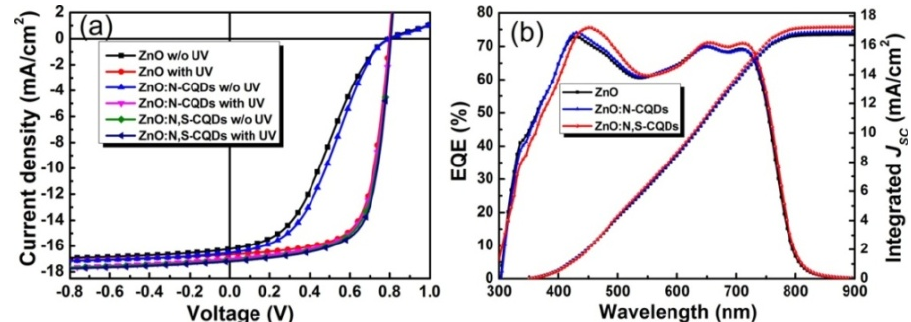
Figure 12. ( a ) J-V curves without and with UV treatment and ( b ) EQE spectra with UV treatment of ZnO-, ZnO:N-CQD-, and ZnO:N,S-CQDs-based PTB7-Th:PC71BM solar cells. Reprinted with the permission of Reference [99]. Copyright 2019 American Chemical Society. Table 2. Photovoltaic (PV) parameters of the devices with different electron transport layers (ETLs).